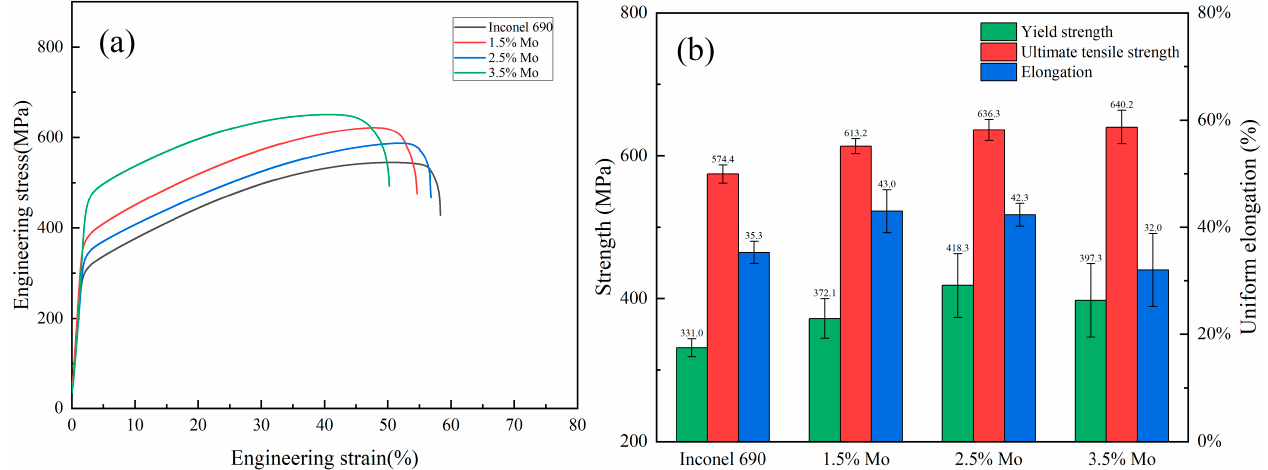
Figure 8. Comparison of tensile properties of different samples: ( a ) Engineering stress-strain curves; ( b ) Comparison of yield strength, ultimate tensile strength, and elongation.